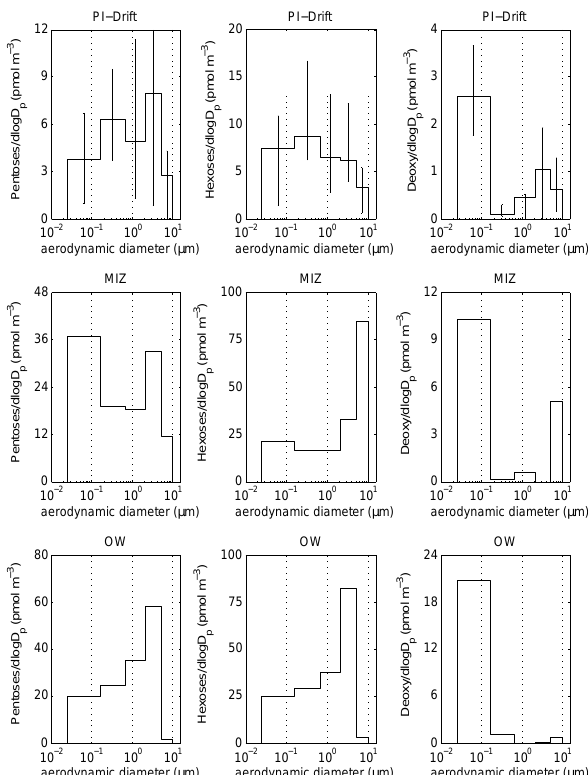
Fig. 4. Size distribution of particulate pentoses, hexoses and deoxy- sugars collected over the pack ice during the PI-drift (upper panel), at the MIZ (middle panel), and in the OW (lower panel). Error bars indicate the 25th and 75th percentile